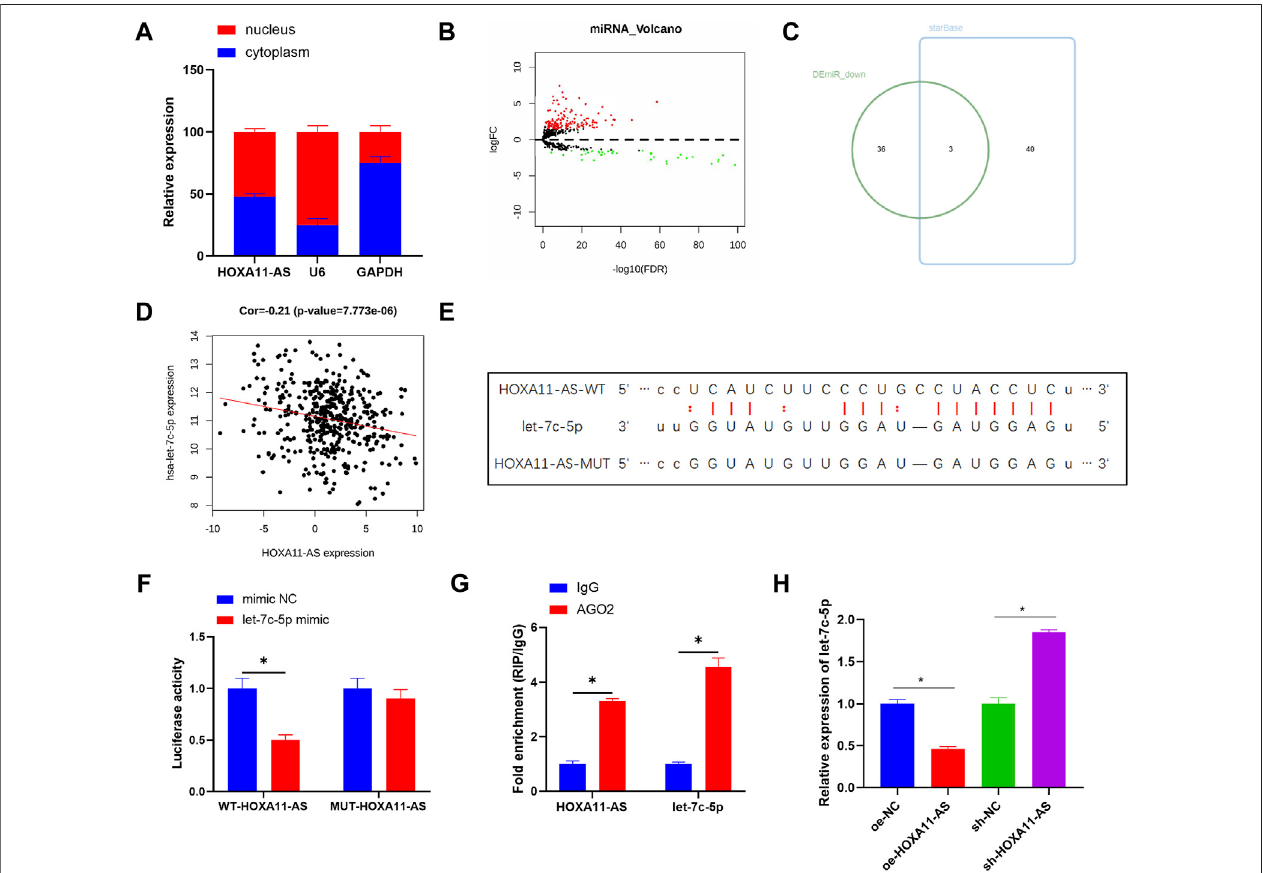
FIGURE 2 | HOXA11-AS sponges let-7c-5p. (A) Subcellular fractionation evaluated the expression of HOXA11-AS in nucleus and cytoplasm. (B) Differential analysis on miRNA in two groups was performed and the result was shown in the Volcano Plot, with red indicating upregulated genes and green indicating downregulated genes. (C) Venn diagram depicted the intersection of predicted target miRNAs and differentially downregulated miRNAs. (D) The scatter plot described the correlation between HOXA11-AS and let-7c-5p. (E) The binding sites between HOXA11-AS and let-7c-5p were predicted on starBase database. (F,G) The target binding of let-7c-5p to HOXA11-AS was demonstrated in RIP assay and dual-luciferase reporter detection. (H) Let-7c-5p expression in each group of cells after transfection was determined in qRT-PCR assay; * p < 0.05.